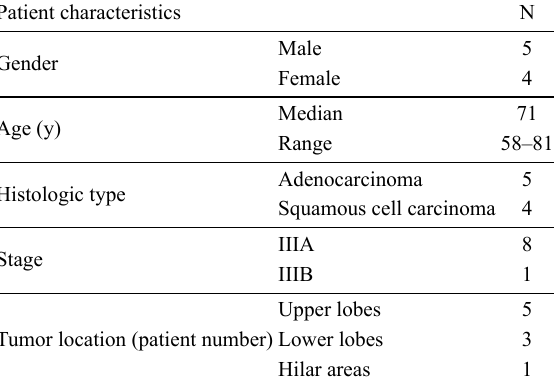
Fig. 3. Functional areas volumes for each patient (high perfu- sion (HP), medium perfusion (MP) and low perfusion